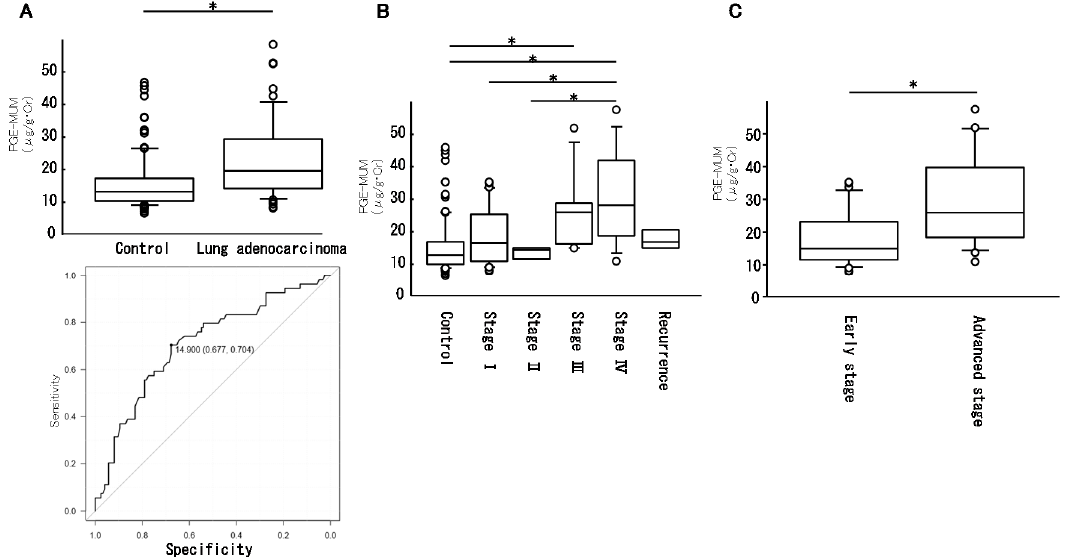
Figure 1. Prostaglandin E-major urinary metabolite ( PGE-MUM) levels in lung adenocarcinoma. PGE- MUM levels in control participants and patients with lung adenocarcinoma are shown ( A ; top panel). The bottom panel in A is the result of ROC curve analysis. Patients with lung adenocarcinoma were classified into five categories (stage I, II, III, IV, recurrence), and the PGE-MUM levels in each group are shown in B . A comparison of PGE-MUM levels in patients with advanced-stage disease (III, IV, and recurrence) and early-stage disease (I and II) is shown in C . (* p < 0.05).